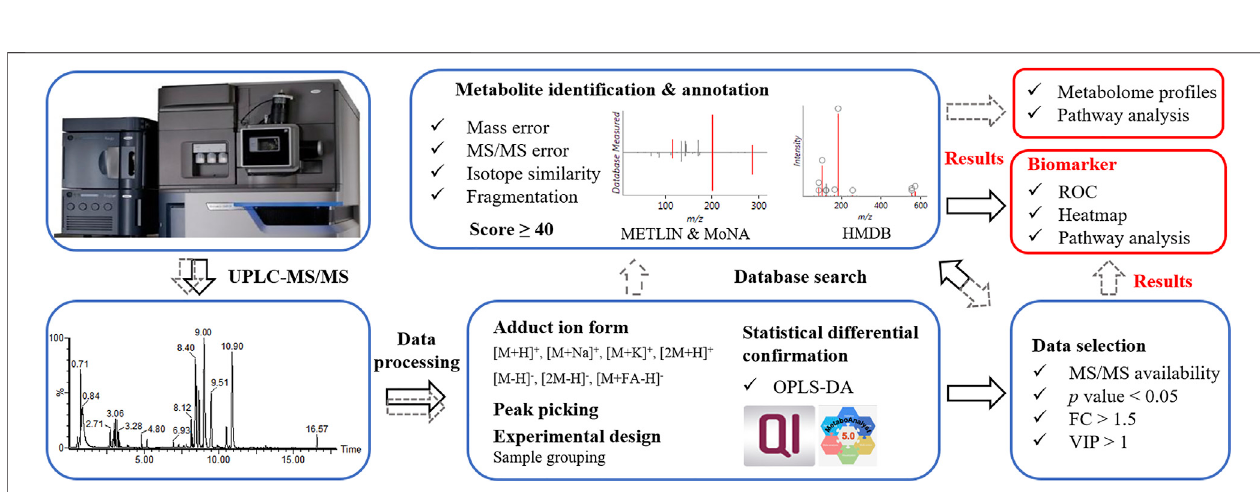
FIGURE 2 | Data processing procedures. Grey dash line referred to a routine data processing procedure; black solid line referred to the proposed simpli fi ed procedure.